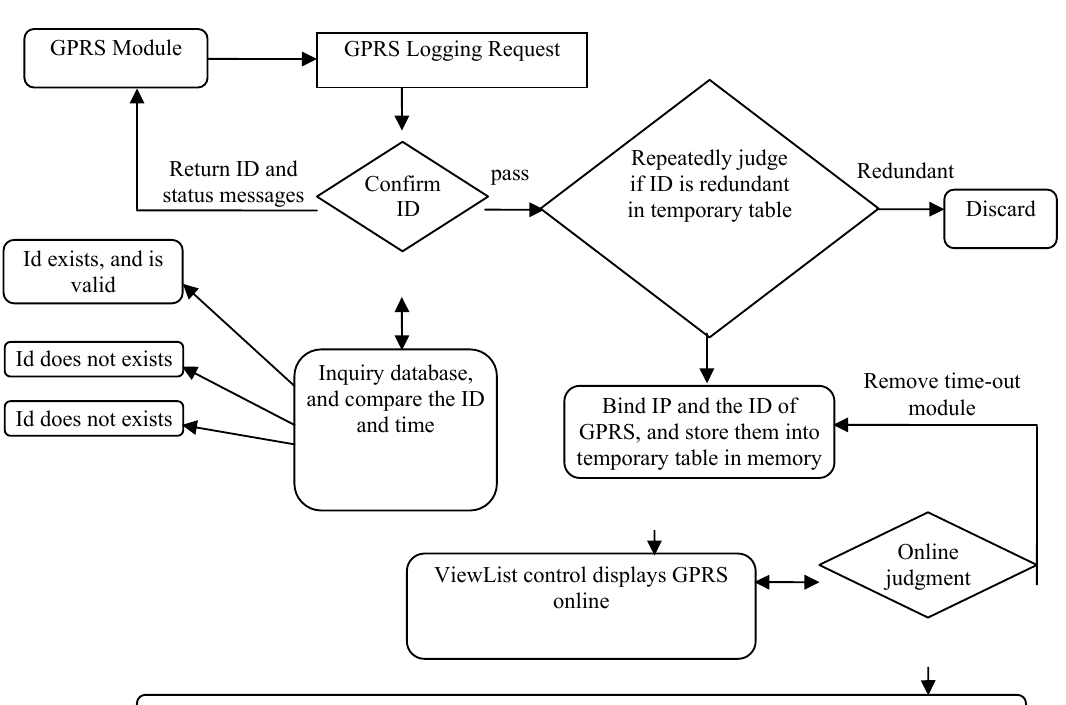
Figure 15. TCPServer workflow.